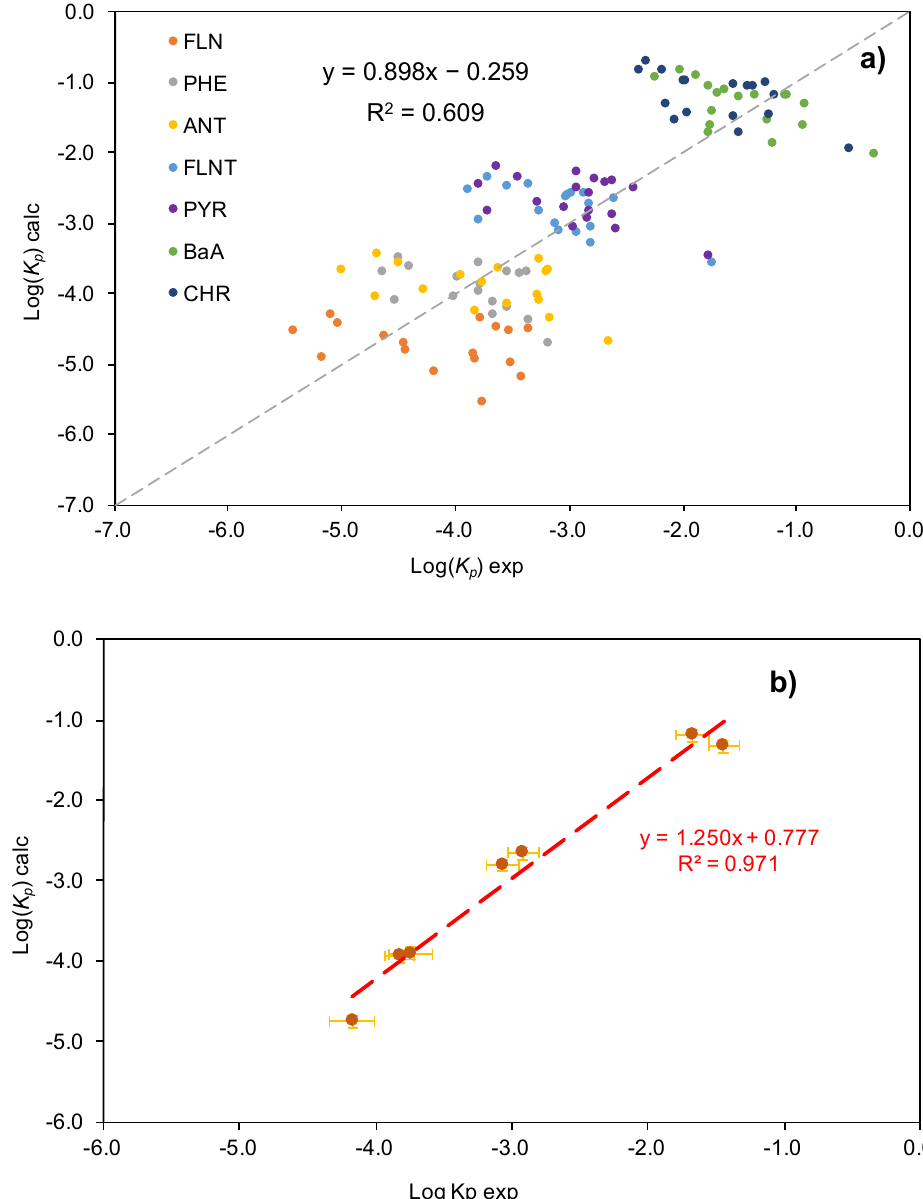
Figure 12. Experimental vs predicted Kp for semi-volatile PAHs (from FLN to CHR) for: ( a ) each collected sample and PAH species ( n = 133); ( b ) each PAH species averaged along the cruise ( n = 7).